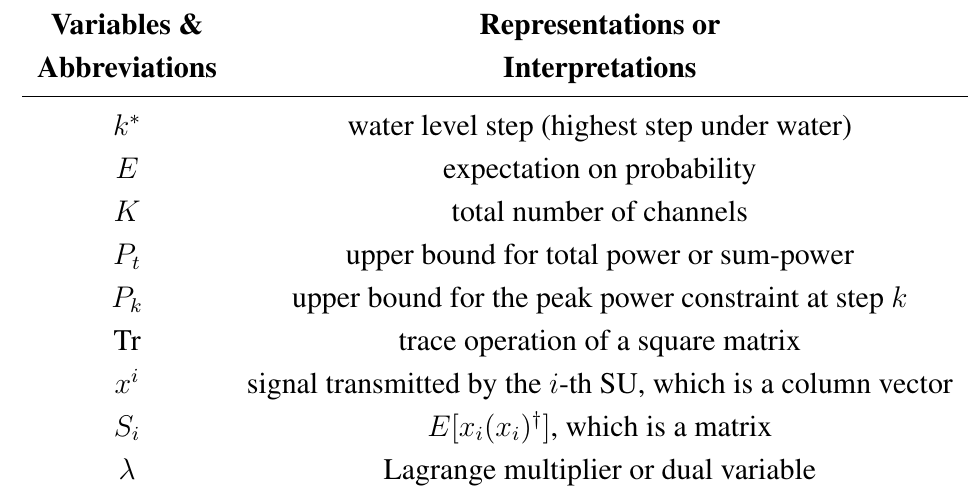
Table 1. List of variables and abbreviations. SU, secondary